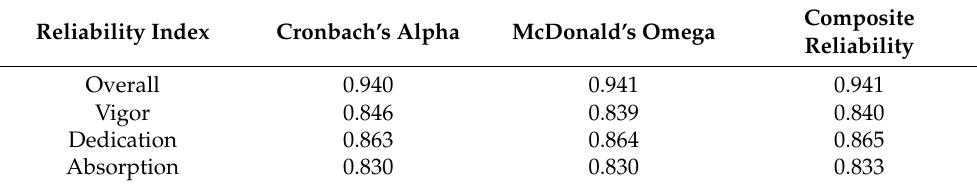
Table 4. Reliability indices for overall and each